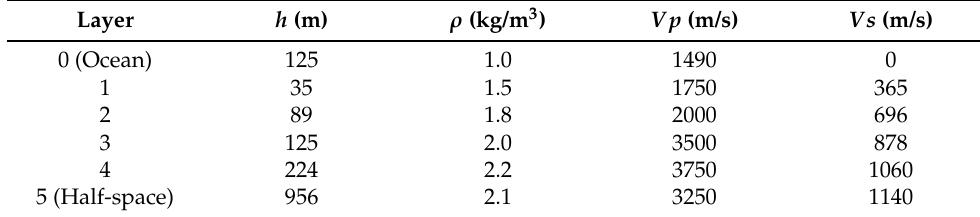
Table 4. Geoacoustic model for Case 1.